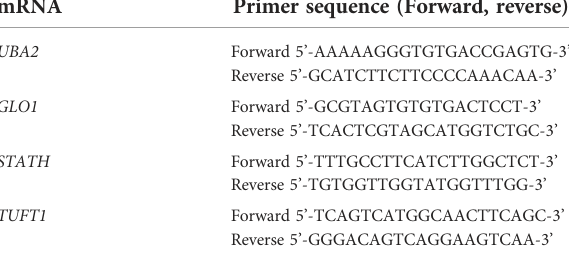
TABLE 2 Nucleotide sequences of primers used to amplify genes differentiated in the study samples (group A and B) from the control samples (group C) by the